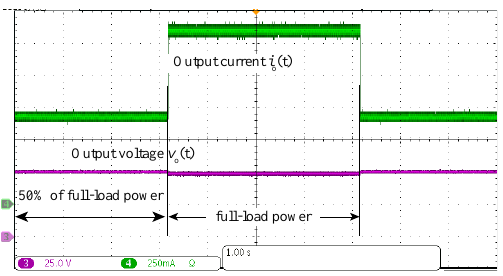
Figure 12. Transient waveforms of the output current i o ( t ) and voltage v o ( t ) .